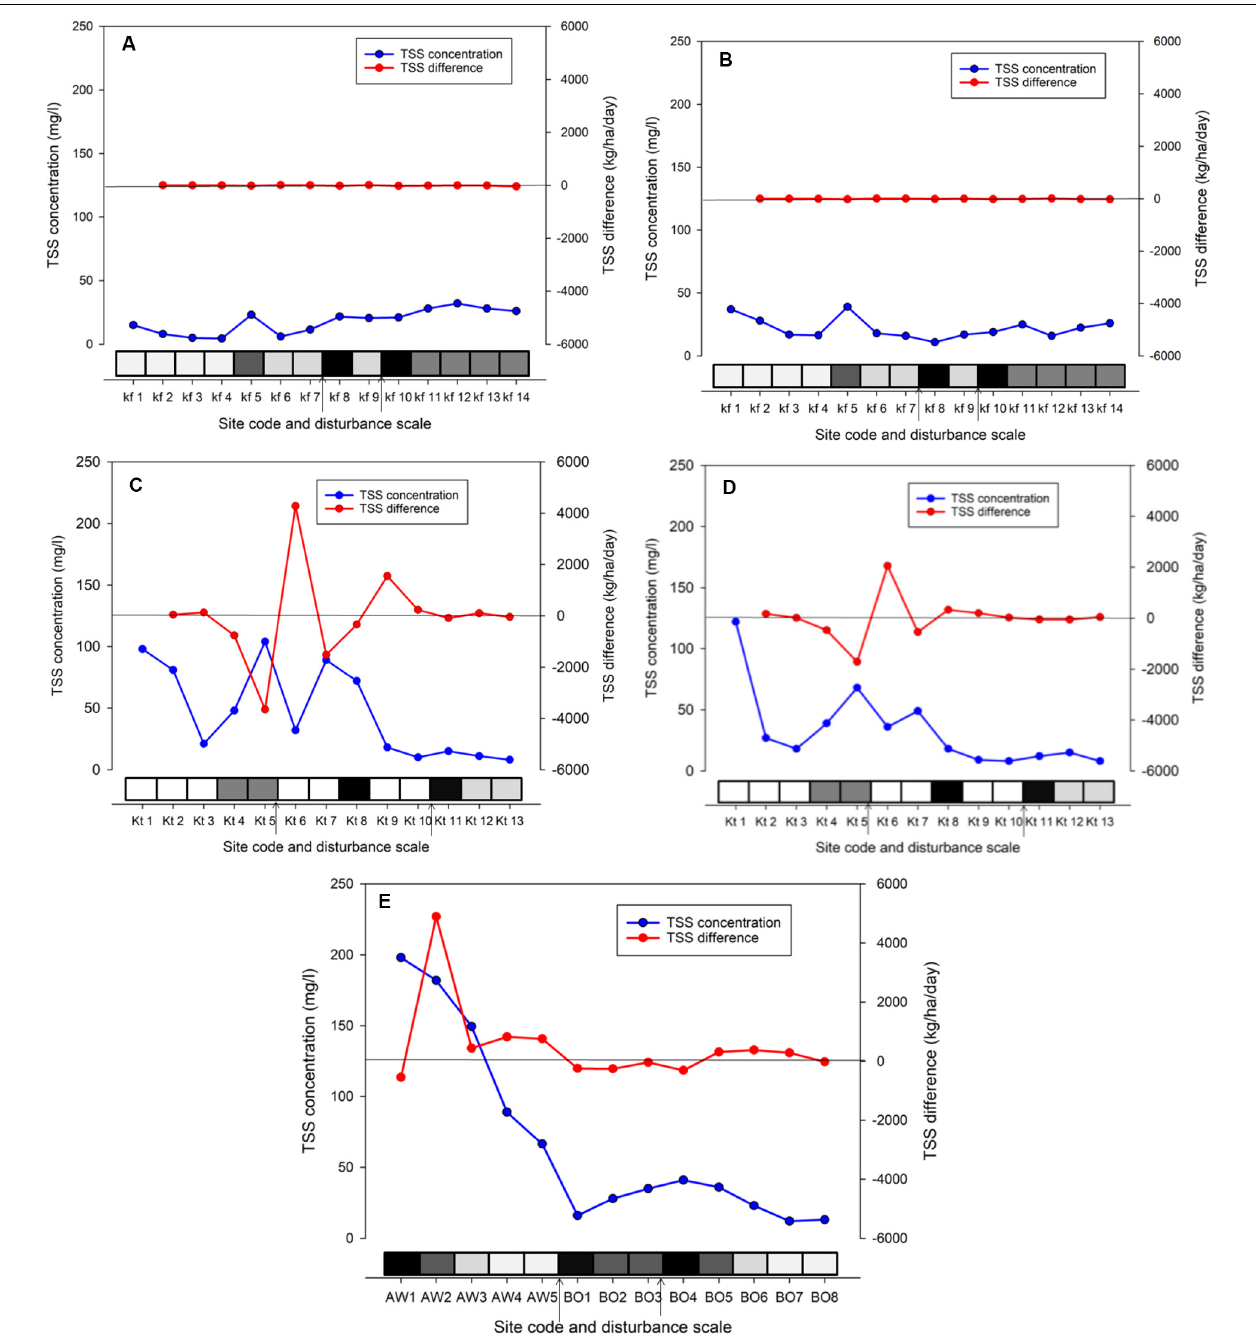
FIGURE 2 | Total Suspended Solids (TSS) concentration and difference in Kofe (A) , Kito (C) and Awetu-Boye (E) wetlands during wet season and Kofe (B) and Kito (D) during the dry season. Disturbance condition along the wetland ranged from very low (white) to very high (black). A black arrow indicates a site where a tributary enters into the main